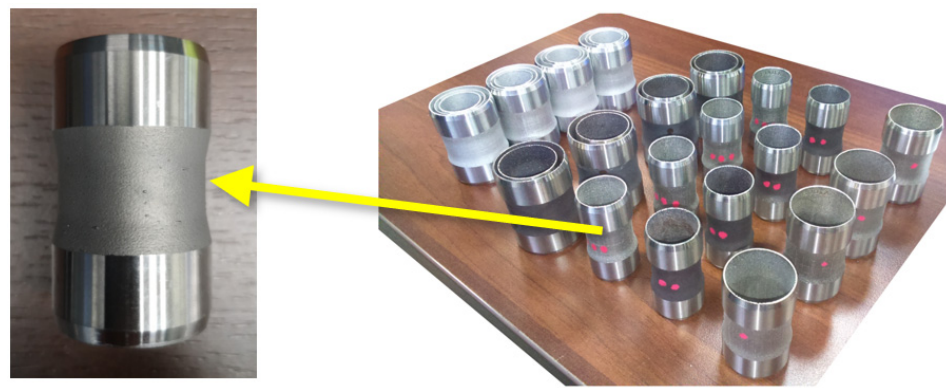
Figure 5. Pressure fatigue samples.